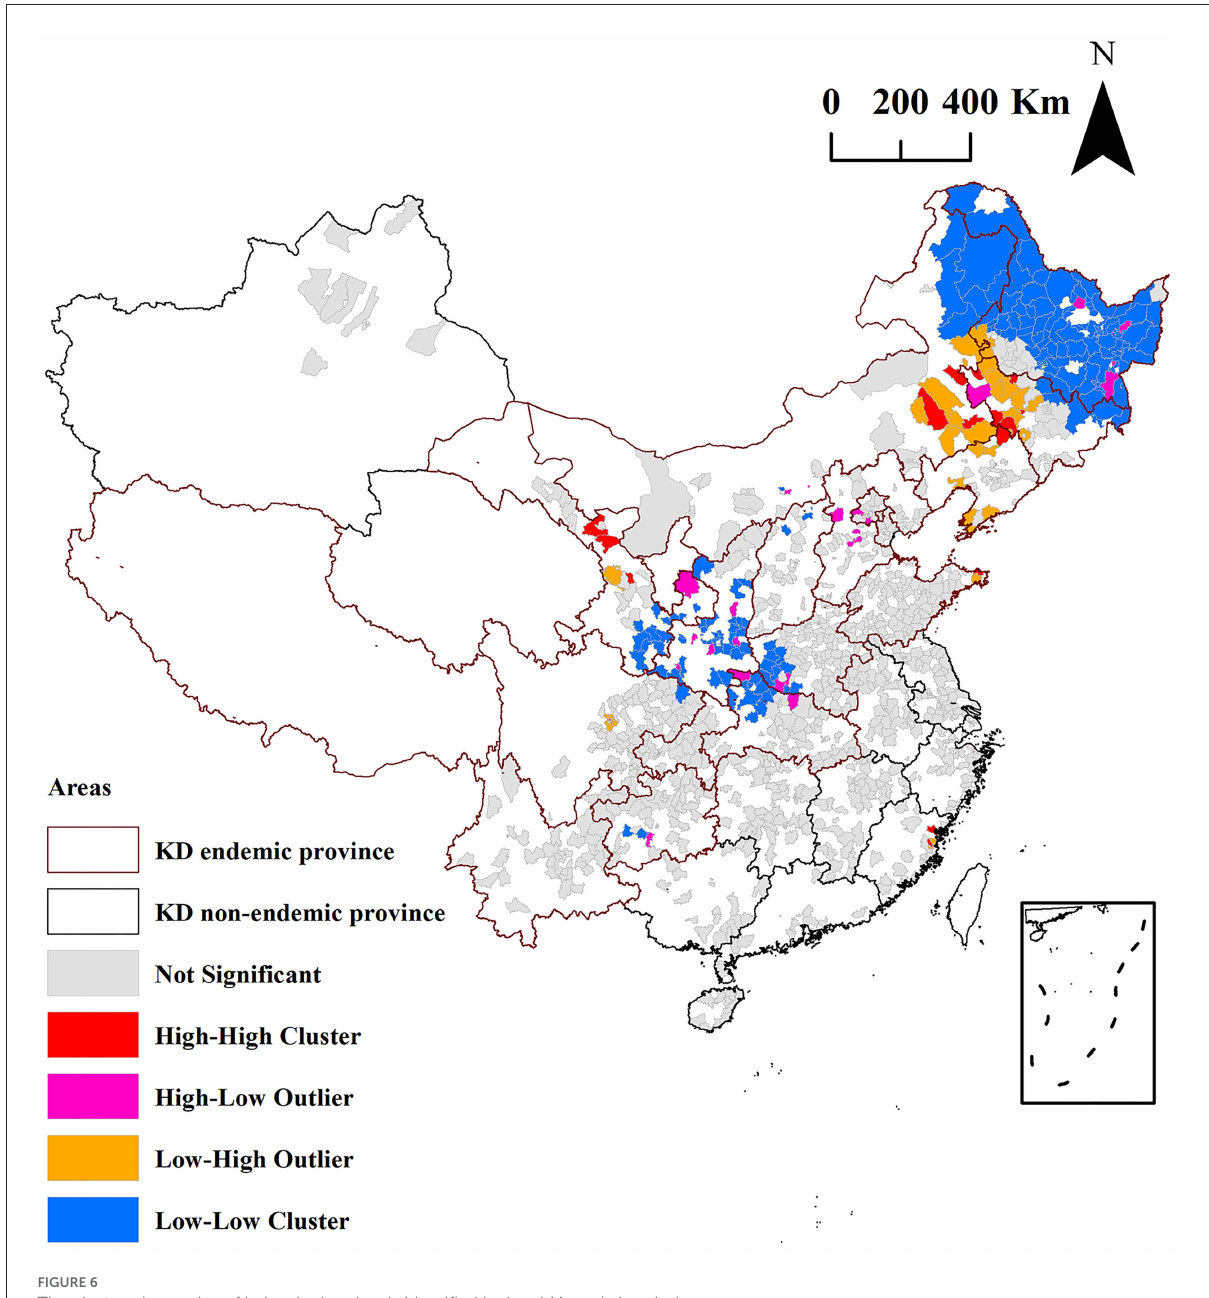
FIGURE6 The clustered counties of hair selenium levels identified by local Moran’s I